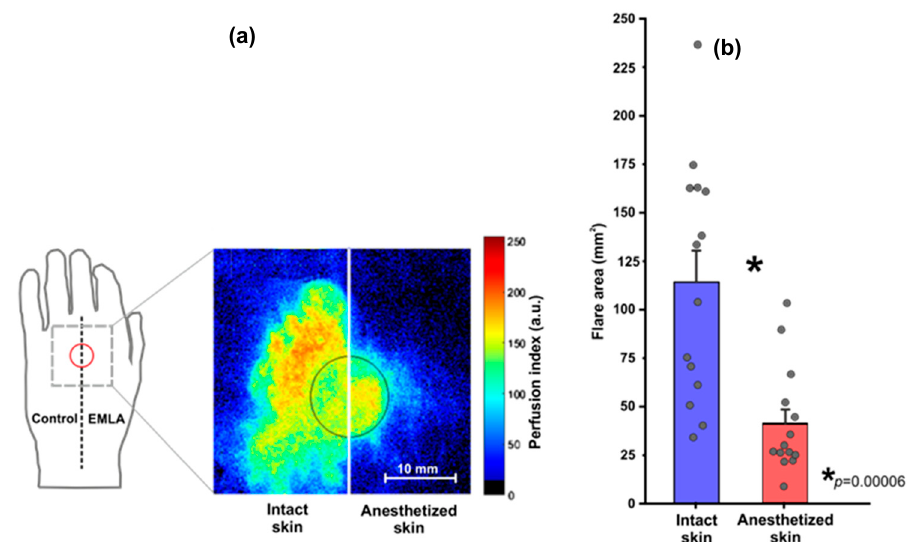
Figure 3. ( a )-Perfusion index map exhibiting topical heating evoked flare response in intact and EMLA treated skin site- circle indicates position of VHP1 probe on the dorsal aspect of palm; typical example from one subject. ( b )-Comparison of flare area in intact and EMLA treated skin region, group (n = 14) mean ± S.E.M., subjects individual measurements marked with black small circles. Statistically significant difference is denoted by asterisk.